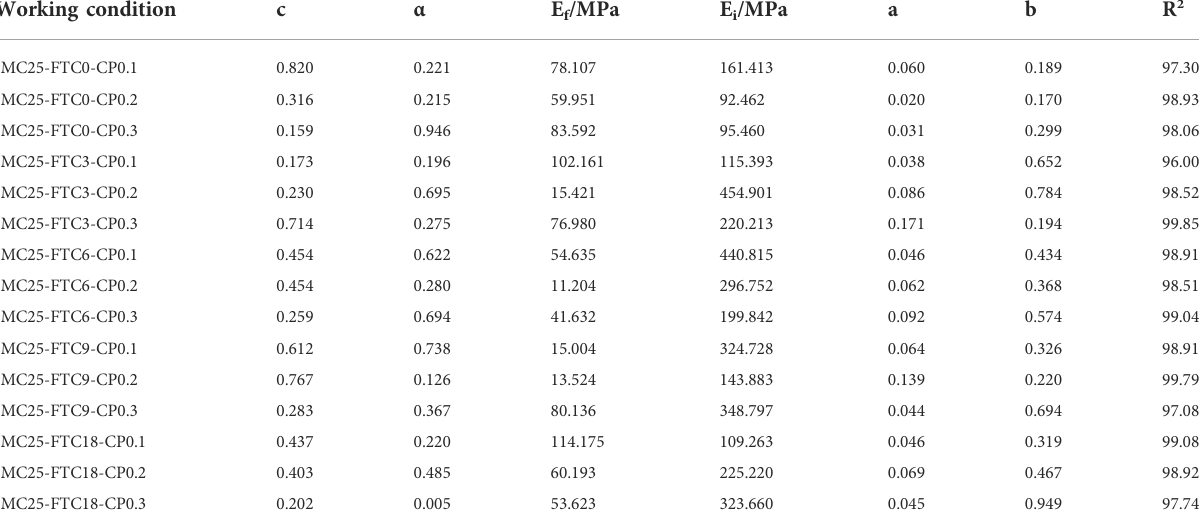
TABLE 4 Parameters of binary medium model of frozen silty clay. Working